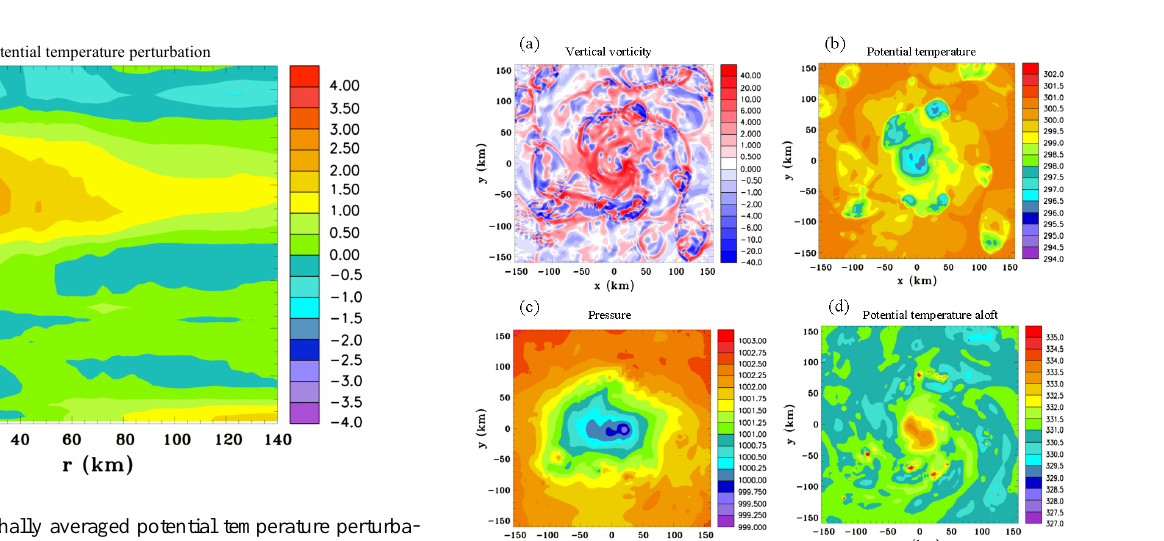
Fig. 14. The azimuthally averaged potential temperature perturba- tion for Experiment 2, at t = 79h. The contour interval is 0.5K. Figure. 14. The azimuthally averaged potential temperature perturbation for Experiment 2, at t=79 h. The contour interval is 0.5 K.